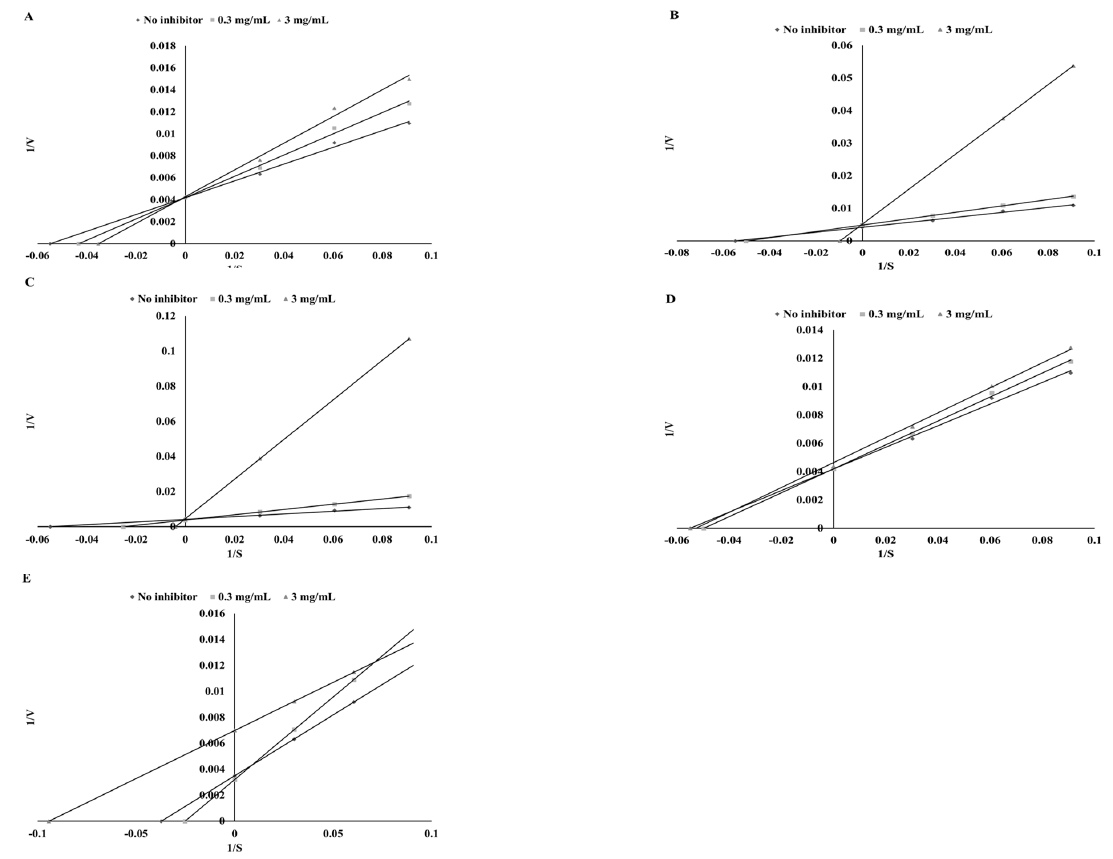
Figure 2. Mode of TPO inhibition by ethanol extracts from parsley ( A ), green coffee ( B ), green tea ( C ), cumin ( D ), and mustard ( E ).